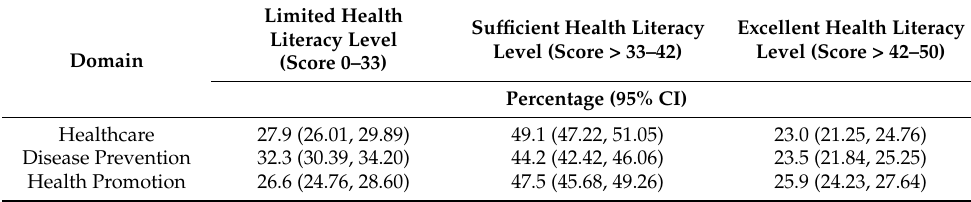
Table 2. Health literacy by